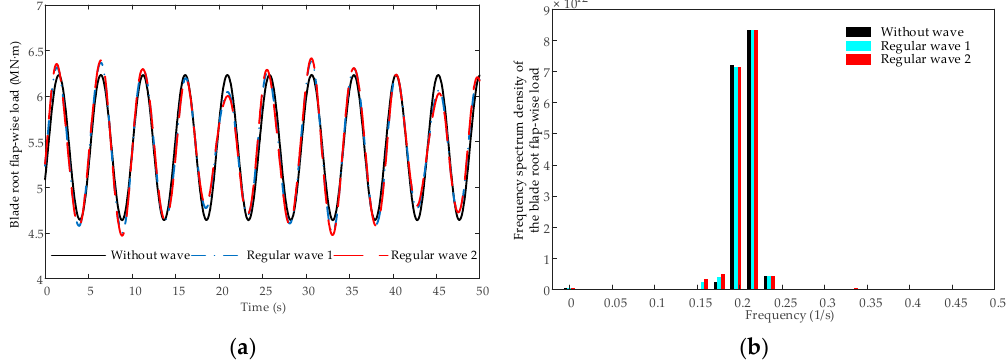
Figure 5. Time domain and frequency domain results of the blade root flap-wise load without and with regular wave: ( a ) The blade root flap-wise load; ( b ) Frequency spectrum density of the blade root flap-wise load.